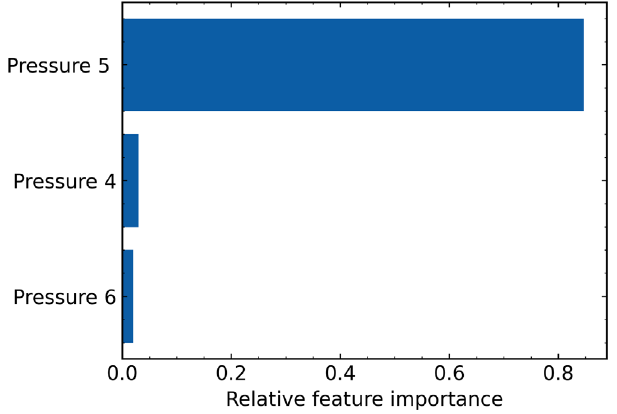
FIG. 10. The three most important trend data features, selected from 30 features in total, for predicting primary breakdowns with trend